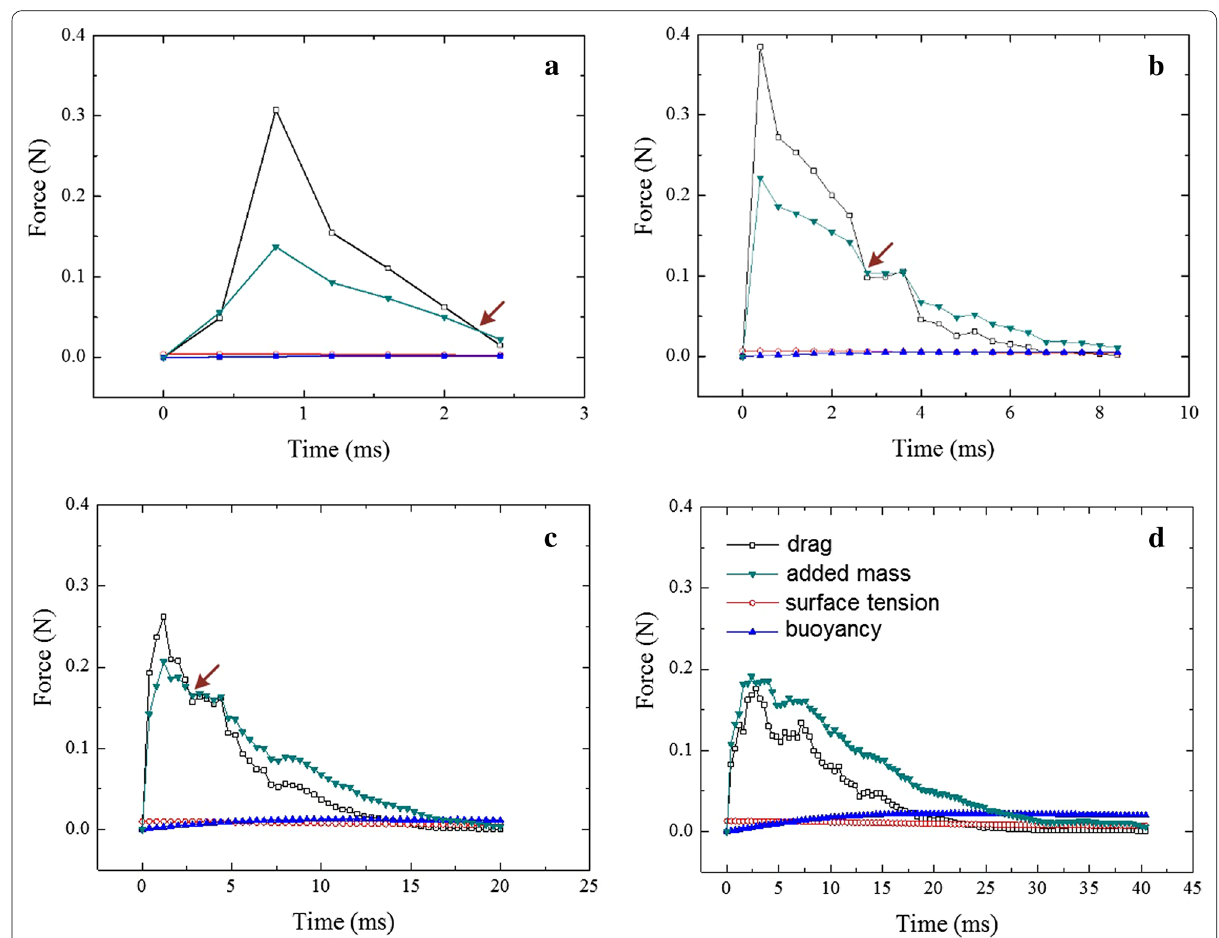
Fig. 5 The change of the magnitude of four force elements according to time for each rod length: a 2 cm, b 4 cm, c 6 cm, and d 8